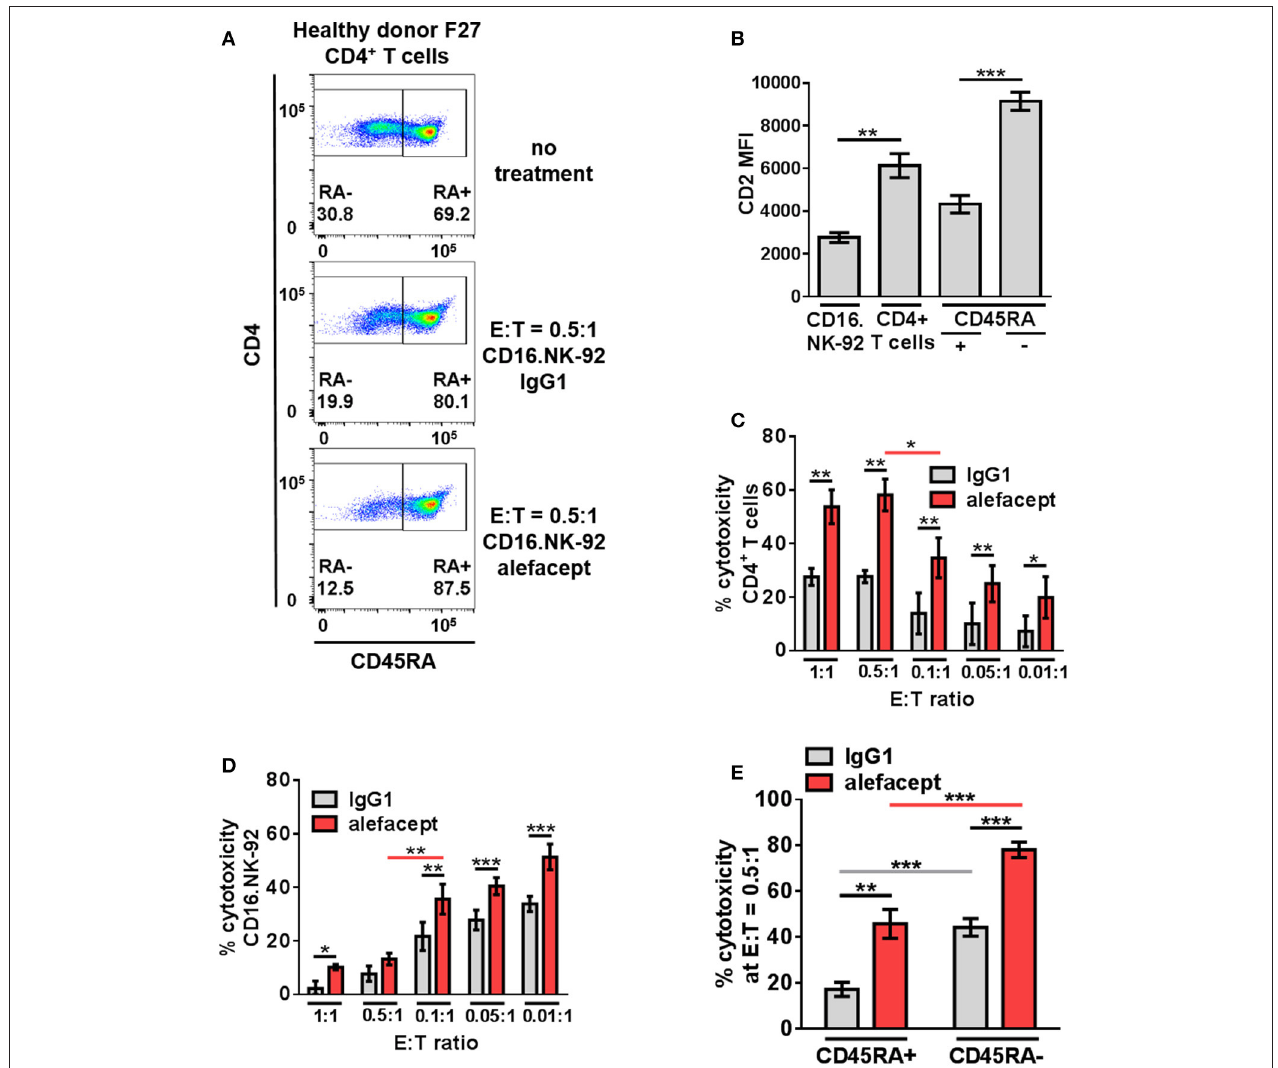
FIGURE 3 | CD16.NK-92 has natural preference to kill CD45RA– CD4 + memory T cells and that is enhanced by alefacept in healthy donors. (A) Representative healthy donor flow cytometry plots from killing assay with CD16.NK-92 and healthy donor CD4 + T cells 19h in co-culture with CD45RA subsetting shown with no treatment, with CD16.NK-92 and 10 µ g/mL alefacept or IgG1 control antibody. (B) CD2 MFI of CD16.NK-92, and CD4 + T cells. (C) Percent cytotoxicity of CD4 + T cells in killing assay with CD16.NK-92 after 19h in co-culture with 10 µ g/mL alefacept or IgG1 control antibody and E:T ratio dose response, as measured by absolute count flow cytometry. (D) Percent cytotoxicity of CD16.NK-92 in killing assay 19h in co-culture with 10 µ g/mL alefacept or IgG1 control antibody and E:T ratio dose response, as measured by absolute count flow cytometry. (E) Percent cytotoxicity of CD45RA + and CD45RA– subsets of CD4 + T cells (as shown in C ) at E:T =